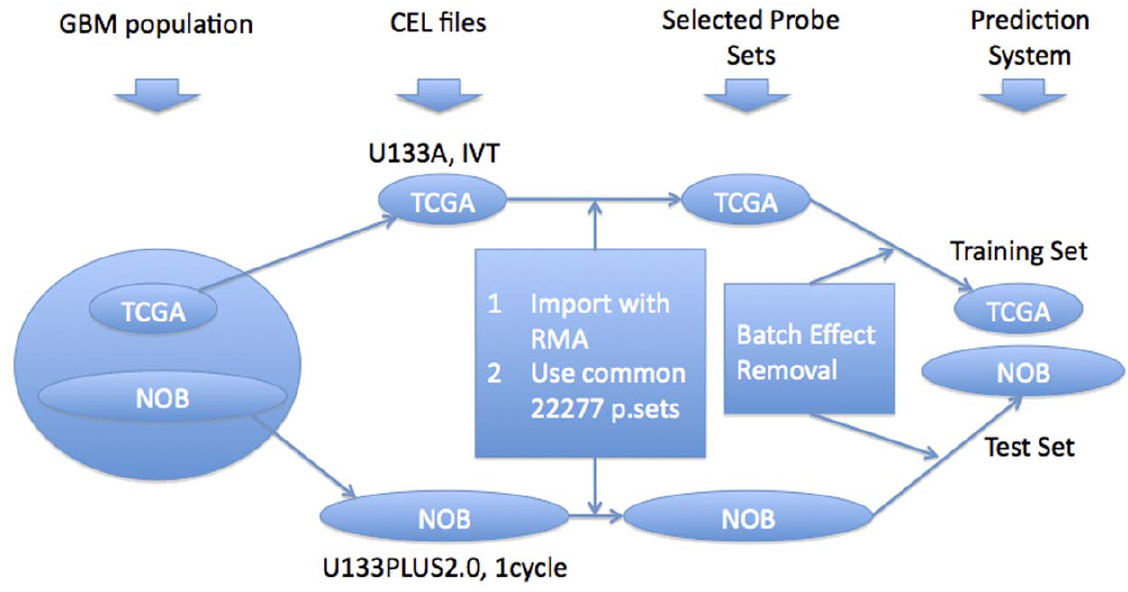
Figure 3. Data processing flowchart for predicting G-CIMP calls of NOB samples from TCGA gene expression data.